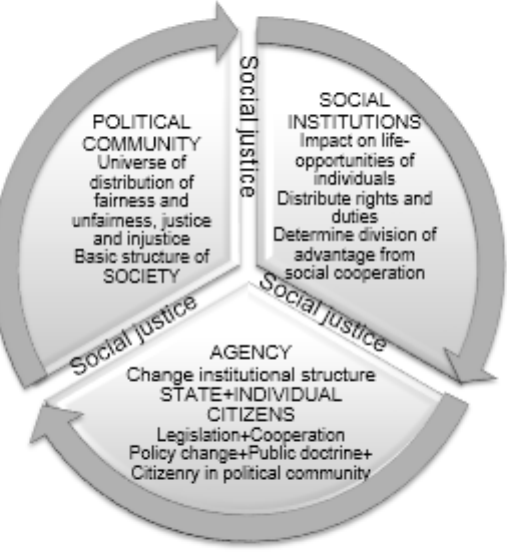
Figure 1 Determinants for social justice praxis (Adapted from Miller,